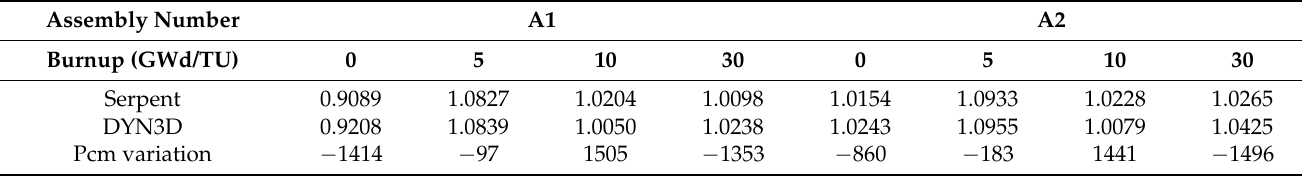
Table 7. Pcm variation at each burnup stage for both fuel